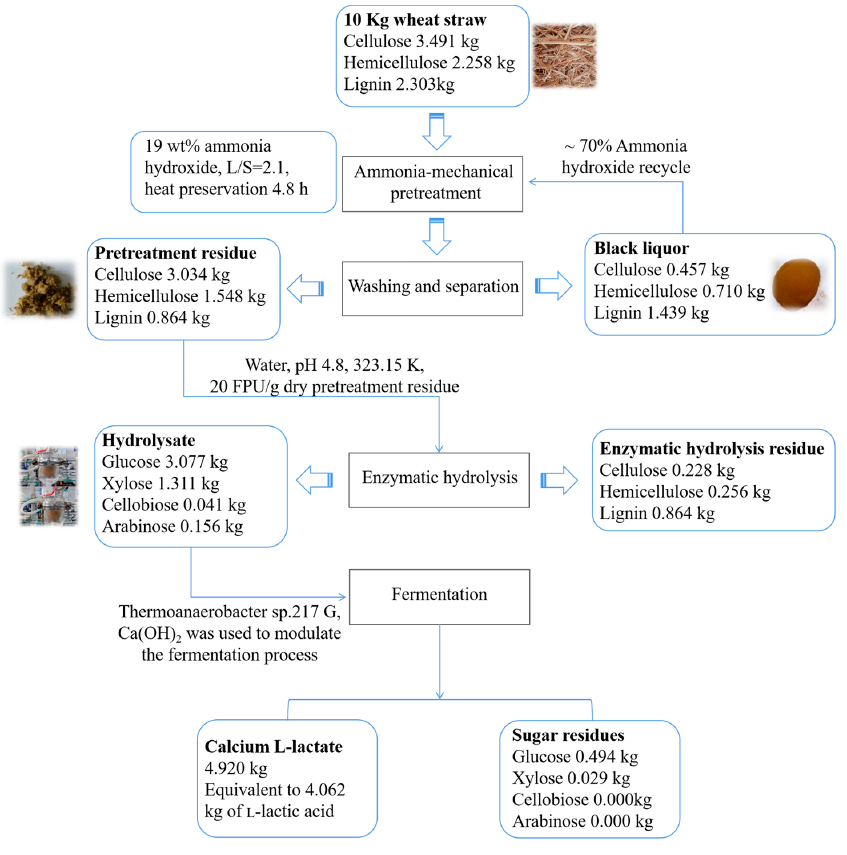
Figure 5. Mass balance of ammonia–mechanical pretreatment, enzymatic hydrolysis and fermenta- tion.